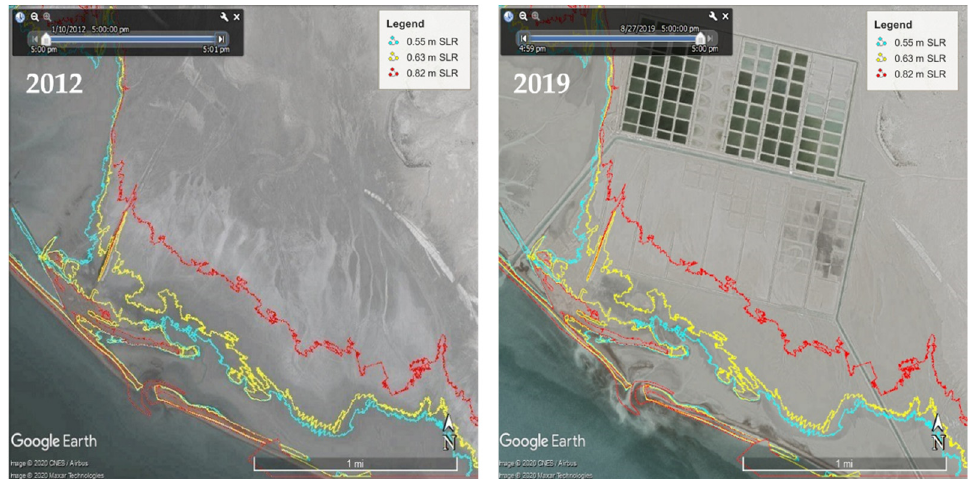
Figure 8. An example of ongoing coastal development in the absence of a SLR adaptation plan along a portion of study area. The blue, yellow, and red lines represent, respectively, the extent of inundation under 0.55, 0.63 and 0.82 m SLR by 2100. The left image shows the state of the coast in 2012 and the right image is from the year 2019 (Google Earth satellite imagery).